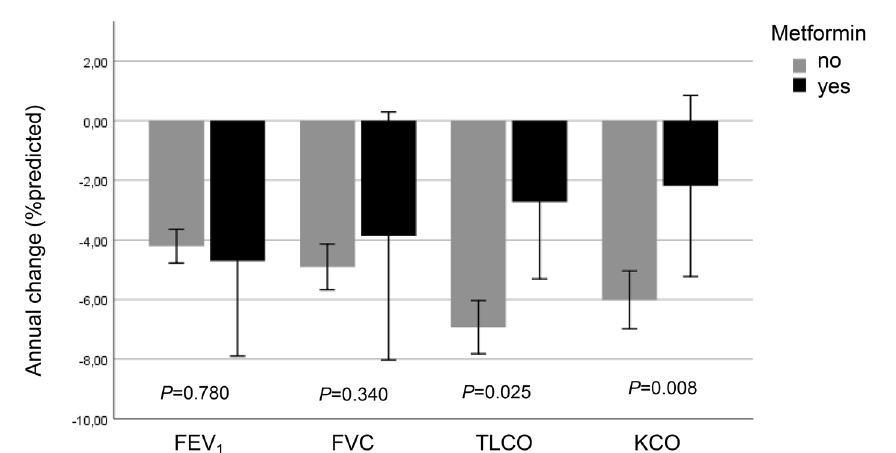
Figure 1. Annual changes in lung function measures. Unadjusted annual changes in lung function measures (mean and 95%-confidence intervals) for the two groups receiving either no metformin (light bars) or metformin as continuous therapy (dark bars). Units are %predicted relative to baseline (GLI). For adjusted values see Table 2.